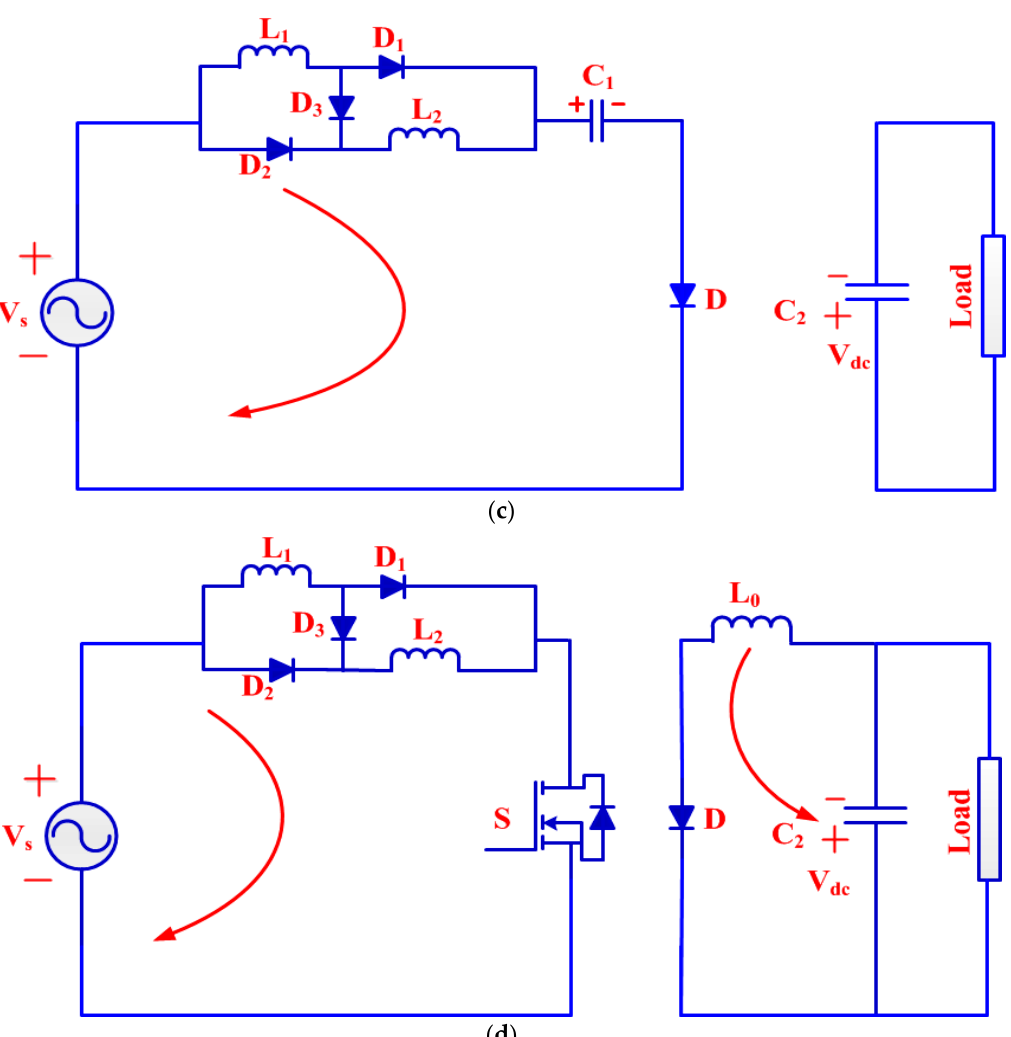
Figure 2. Design of integrated Cuk converter with different intervals of switching period: ( a , b ) continuous conduction mode (CCM), ( c ) discontinuous inductor conduction mode(DICM) and ( d ) Discontinuous Capacitor Voltage Mode (DCVM) modes.